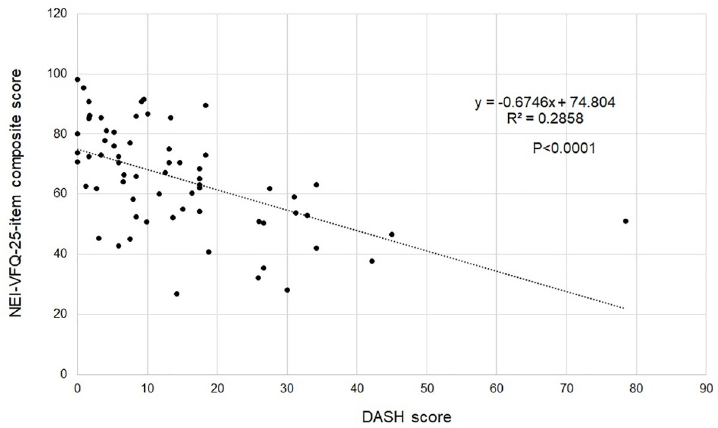
Fig 3. Correlation between NEI-VFQ 25 and DASH examinations. NEI-VFQ 25: National Eye Institute Visual Function Questionnaire 25, DASH: Disabilities of the Arm, Shoulder and